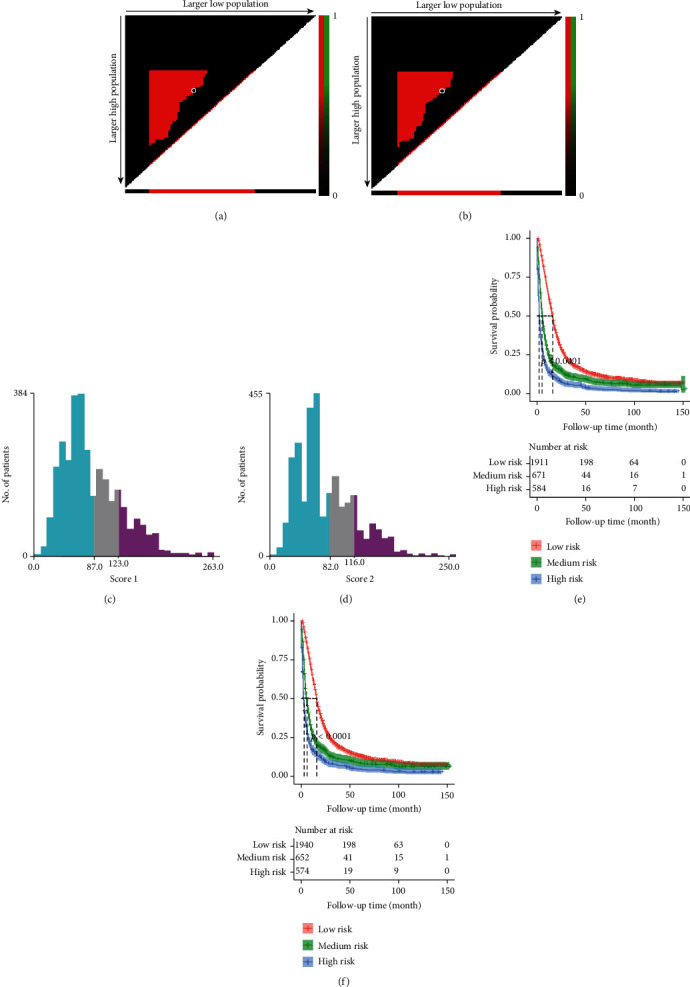
The results of the X-tile program for optimal cutoff points of risk scores. X-tile plot of all patients is displayed in the figure, the risk scores optimal cutoff value of OS marked by the black circle in the (a) is shown by a histogram of the entire cohort (c), and a Kaplan–Meier plot (e); the risk scores optimal cutoff value of CSS marked by the black circle in the (b) is shown by a histogram of the entire cohort (d), and a Kaplan–Meier plot (f). The figure shows the optimal cutoff points for risk scores (87 and 123; 82 and 116).